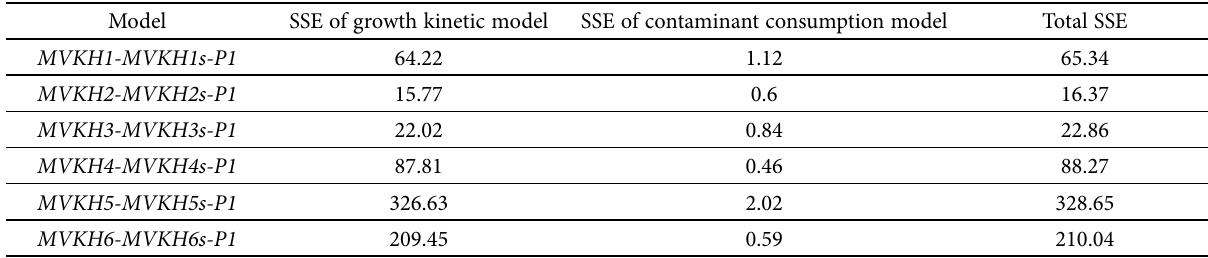
Table 6. The SSE of microbial growth kinetic and contaminant consumption models, as well as total SSE obtained from simulations of the first